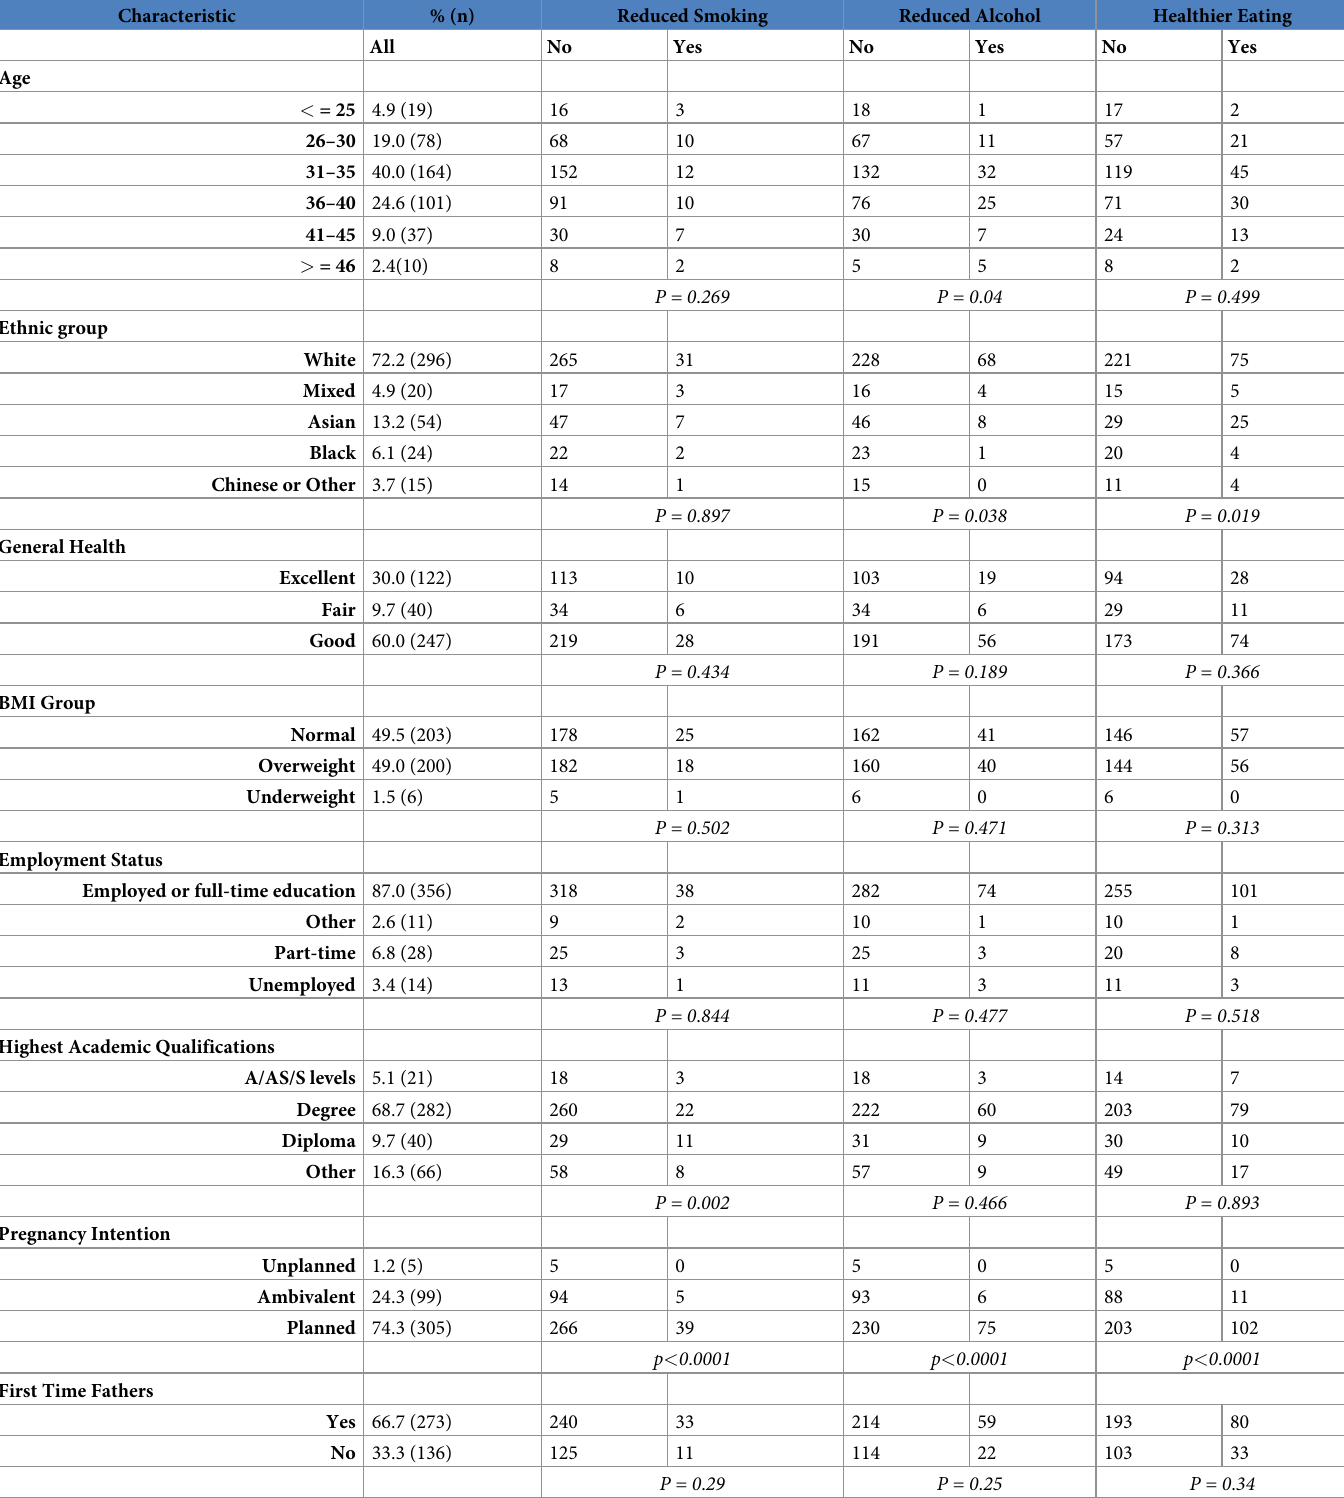
Table 3. Characteristics of the sample by demographic and pregnancy intention for behaviour change.